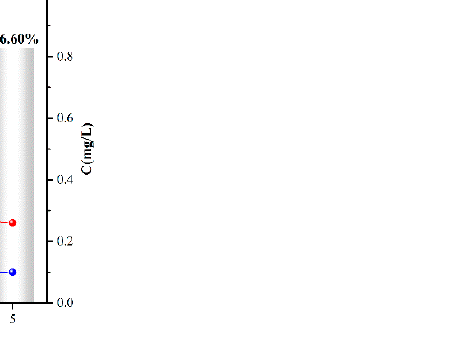
Table 4. The production of H 2 O 2 and •OH in catalytic Fenton-like systems is summarized and compared.